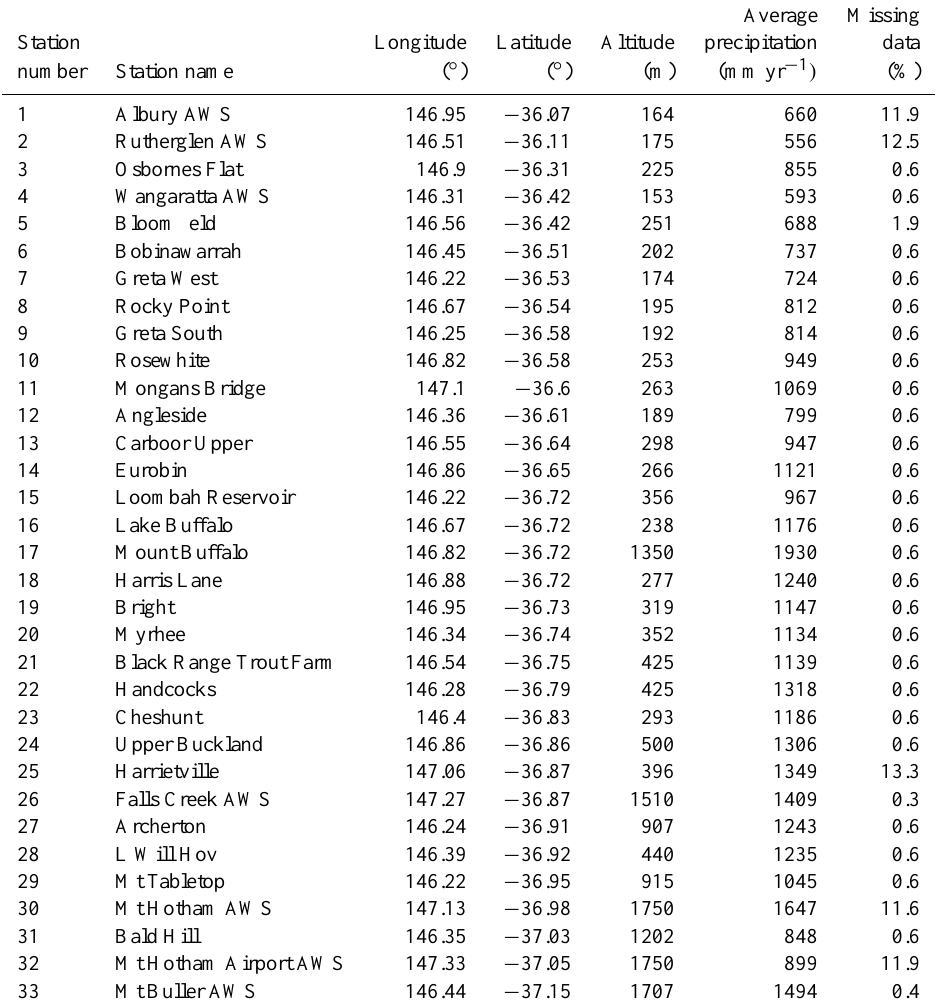
Table 2. Precipitation stations in and near the Ovens catchment. The period of record for the annual average precipitation is September 1991 to February